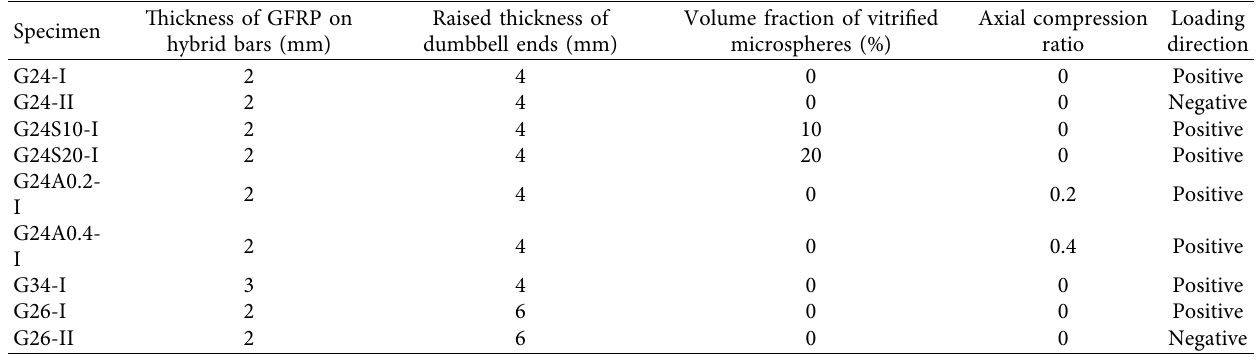
Table 3: Details of test specimens.